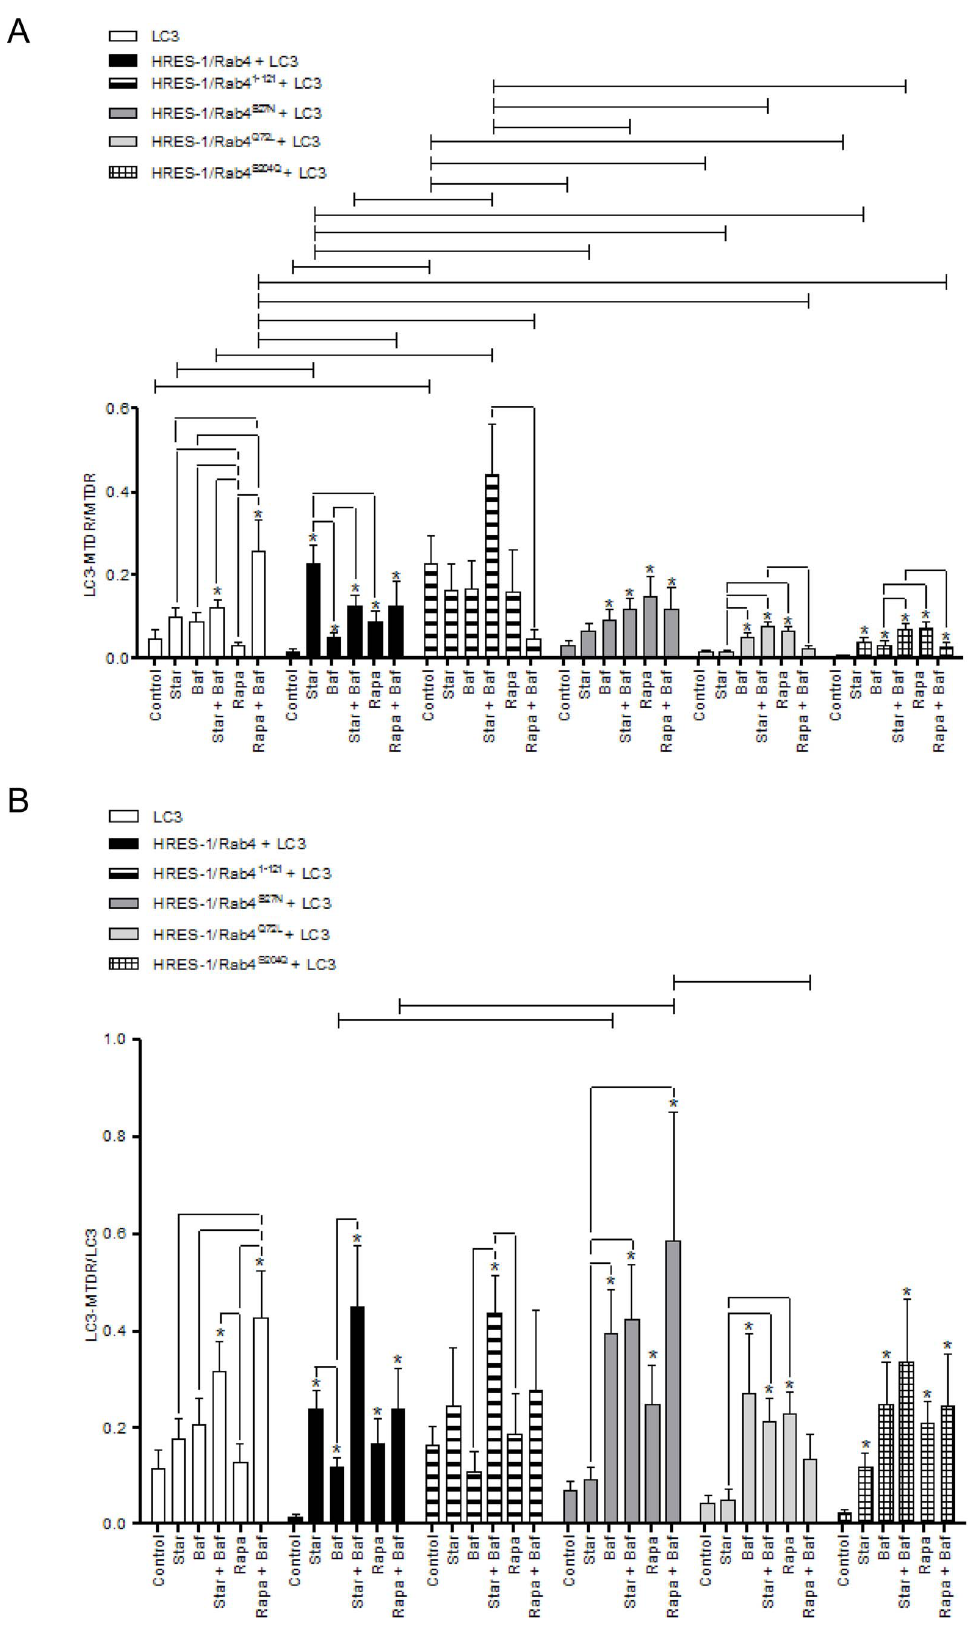
Figure 5. Quantitative analysis of colocalization between LC3 + autophagosomes and mitochondria in HeLa cells transfected with eGFP-tagged HRES-1/Rab4 isoforms and FP650-LC3. Autophagy was induced by starvation (Star) or treatment with rapamycin (Rapa) in the